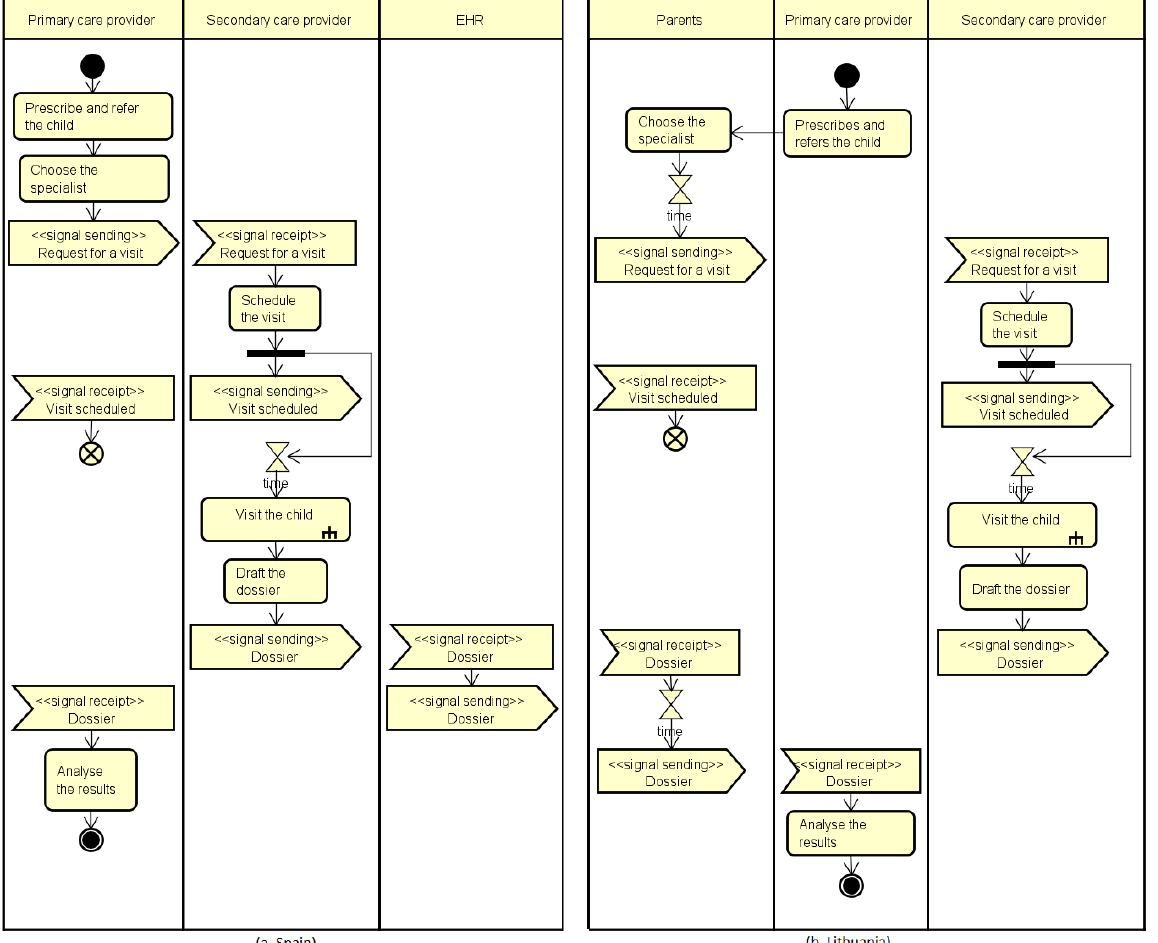
Figure 5. Activity diagrams reporting two control flows: on the left side (Spain), both activities are directly performed by the health professionals, while on the right side (Lithuania), the parents are involved both in the referral and in the communication procedures.